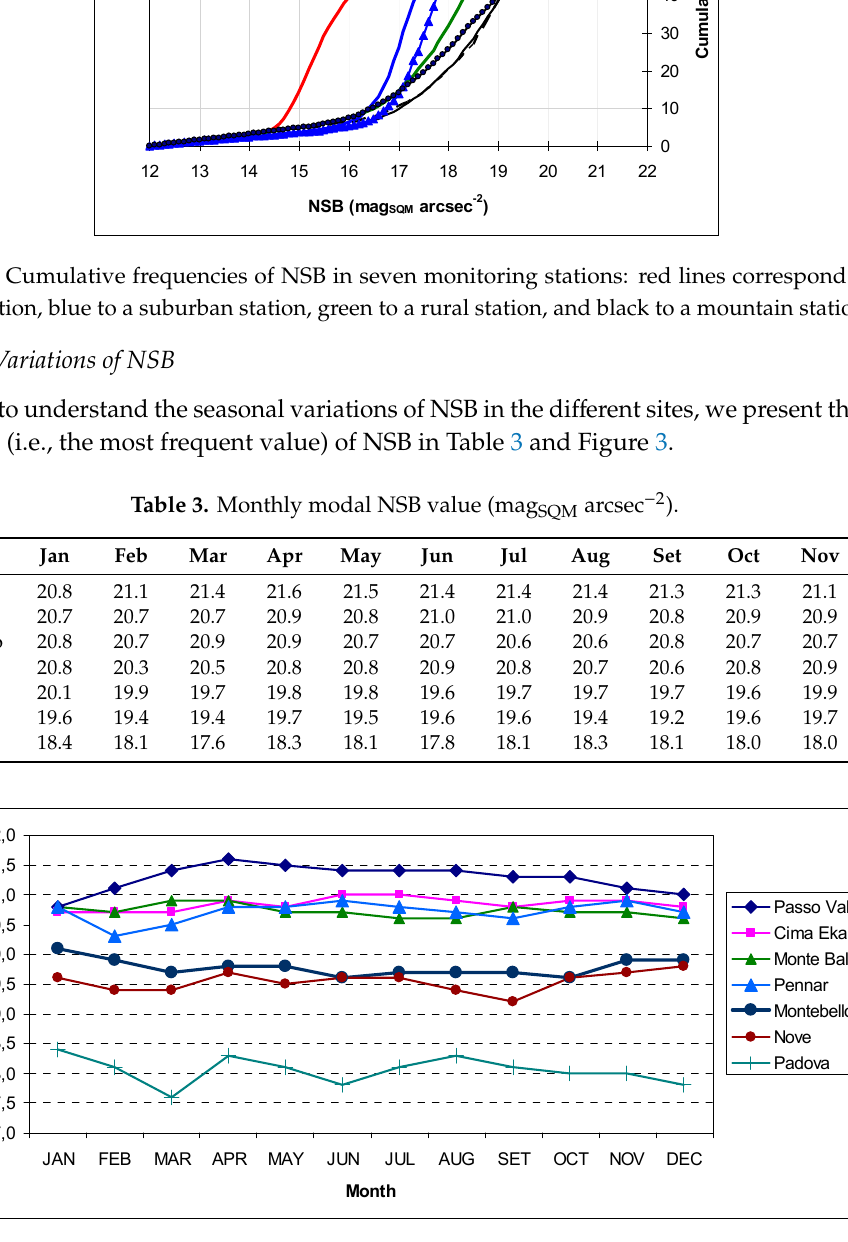
Figure 3. Monthly modal value of NSB during 2018.